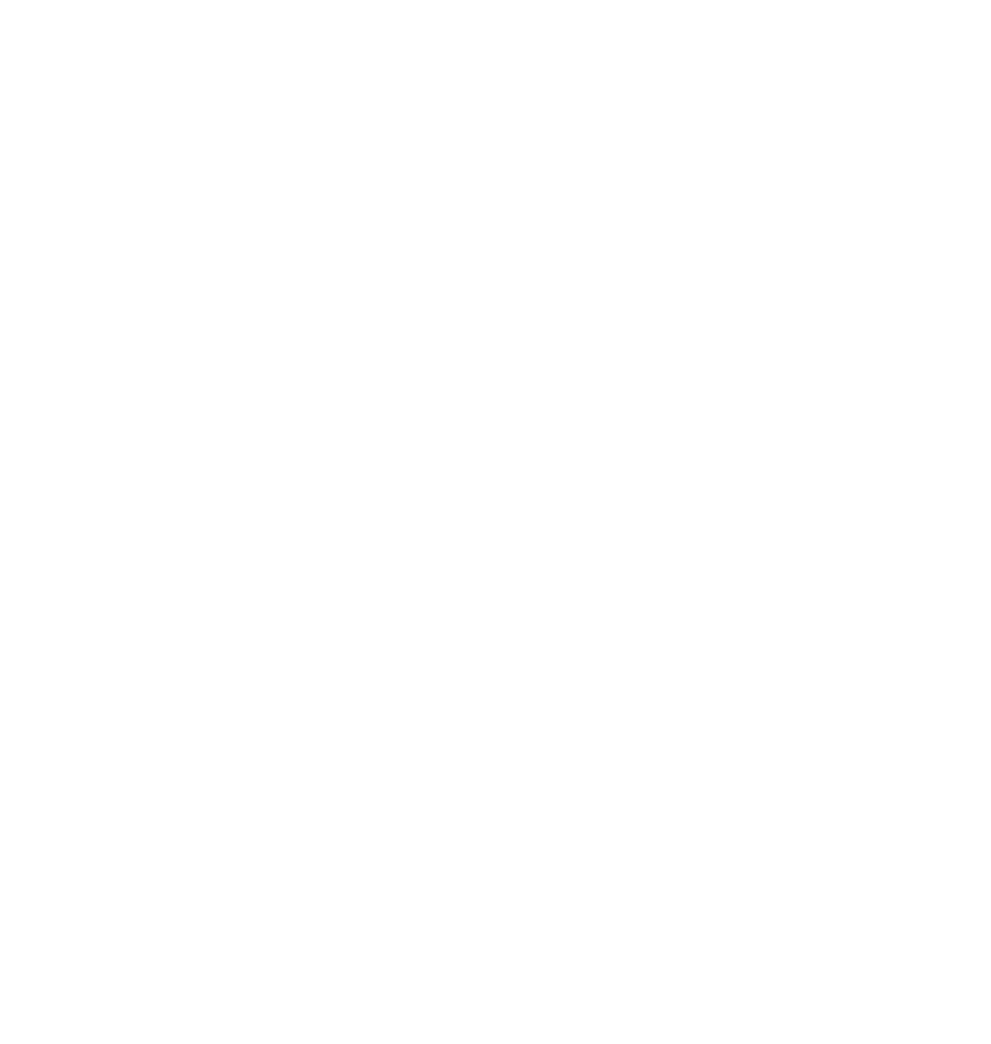
FIGUREA1 | Imaging of neurons expressing either actin-CFP or actin-YFP alone to estimate the bleed-through between two channels under different excitation wave length. PV neurons in cortical slice culture were